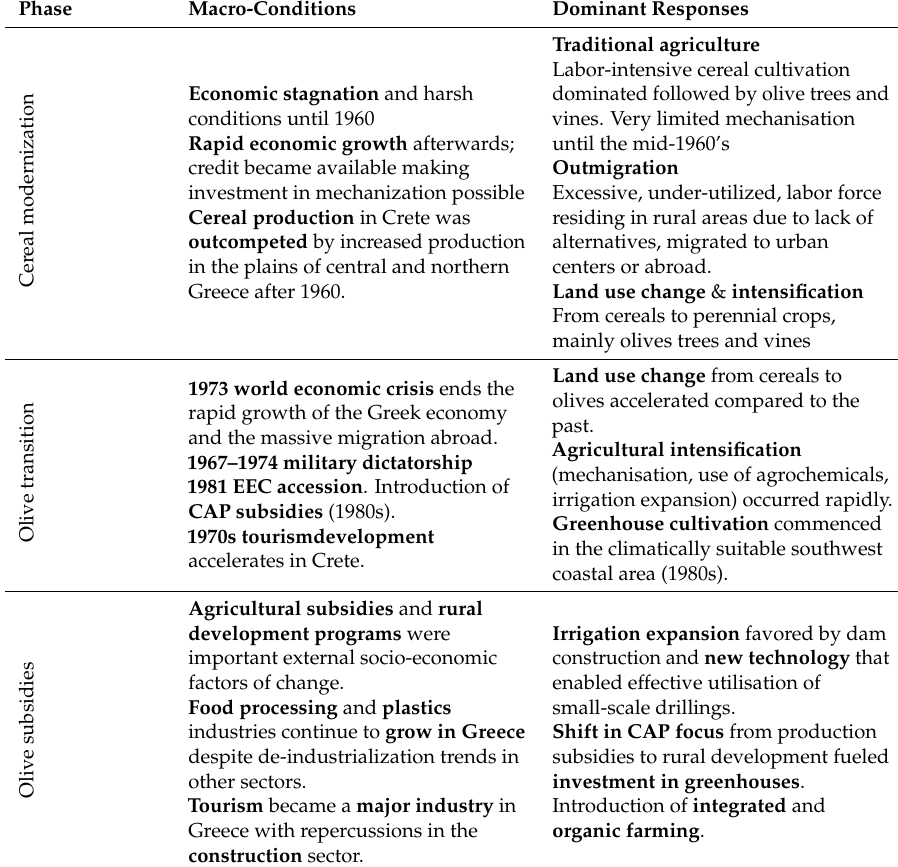
Table 5. Main features of the three phases of the Messara Valley Socio-Ecological